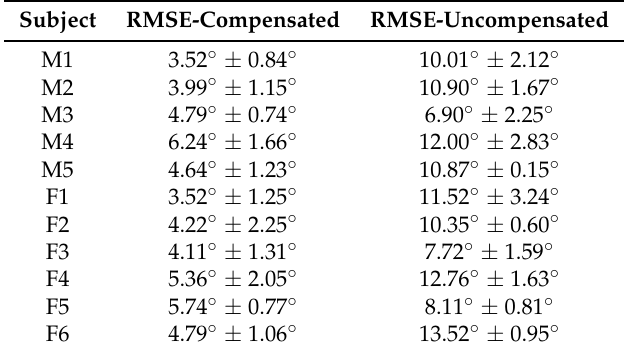
Figure 14. Polynomial regression between the subjects’ arm length (parameter d 3 ) and the coefficients of angular error correction. Table 5. Comparison between RMSEs of the compensated and uncompensated responses for each